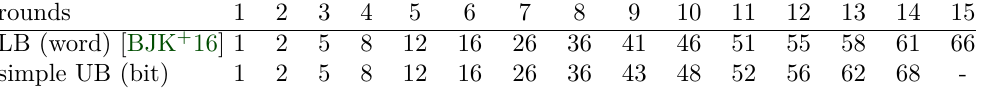
Table 7: Bounds on the number of active S-boxes in the single-key